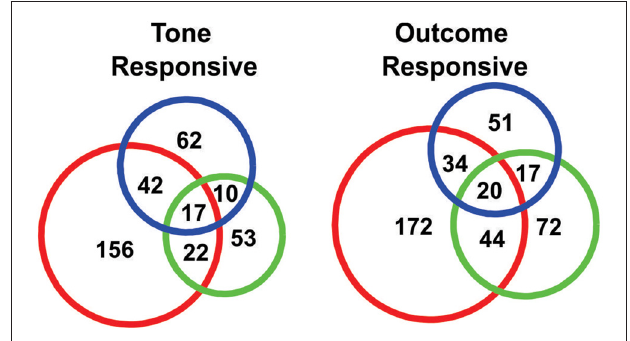
FIGURE 4 | Venn diagrams showing the numbers of “tone responsive” (left) and “outcome response” (right) neurons. Block Specific Background Responses When zooming out from the tone/outcome periods, clear block differences become apparent ( Figure 5 ). The activity